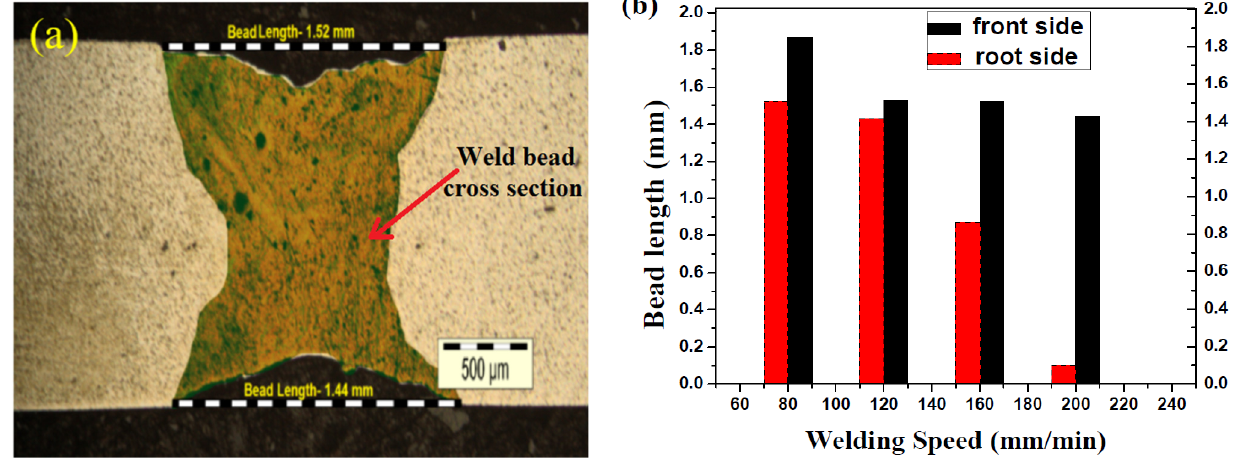
Figure 5. ( a ) Bead length of front and root side of sample A-2 [17]. ( b ) Represents bar chart of weld bead between face side and root